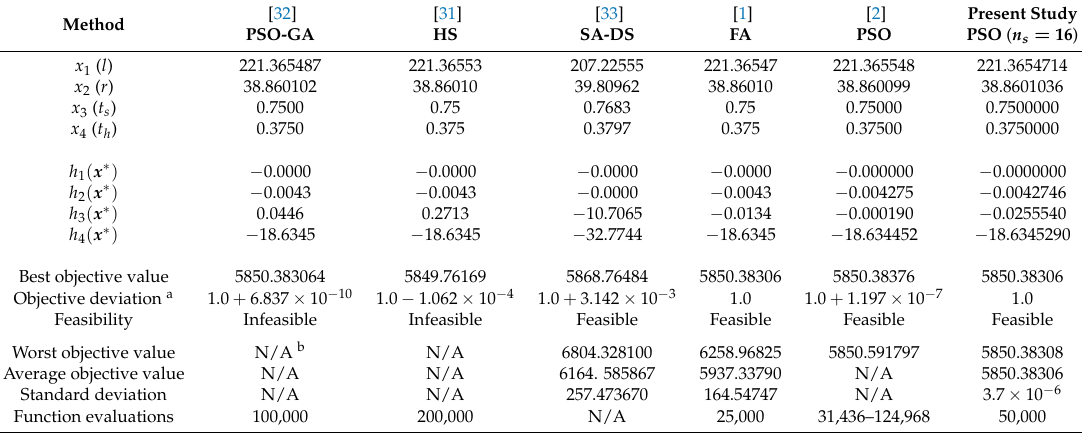
Table 1. Optimization results for the pressure vessel design problem.